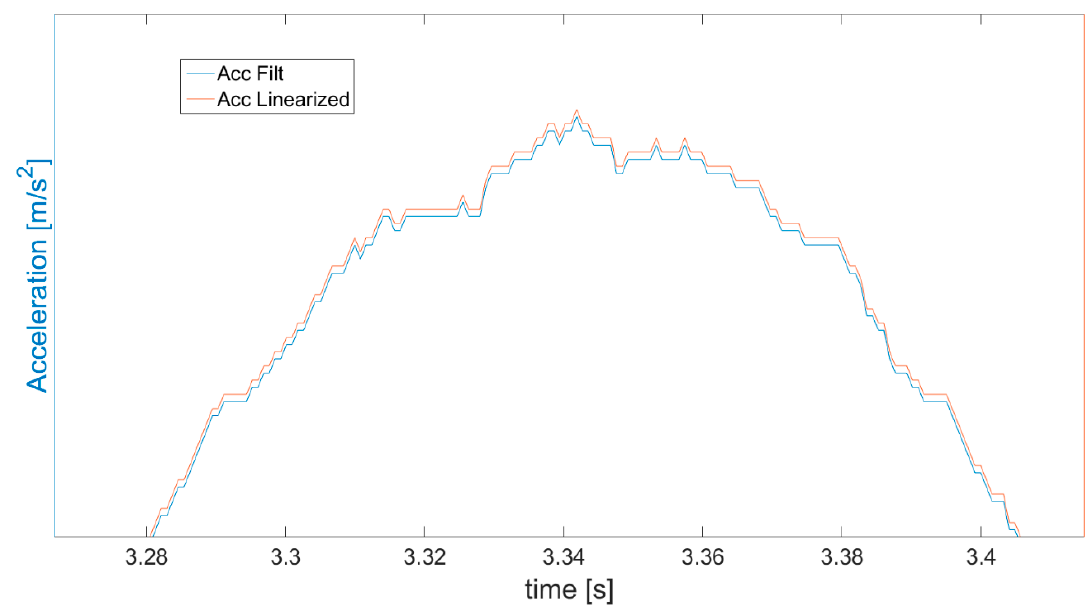
Figure 10. Magnification of part of Figure 9 presenting the difference between accelerations obtained from measurement (blue line) and subjected to symmetrization (red line).